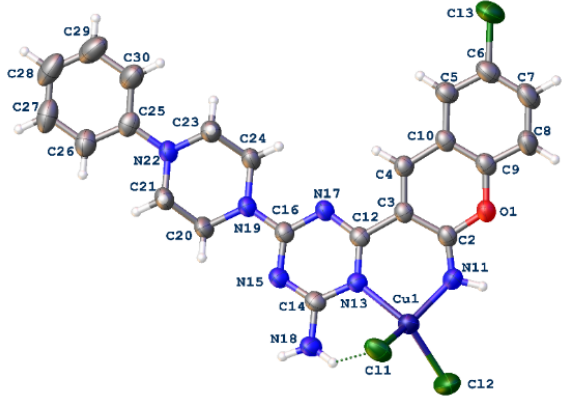
Figure 5. Molecular structure of 2g . Displacement ellipsoids are shown at the 50% probability level.